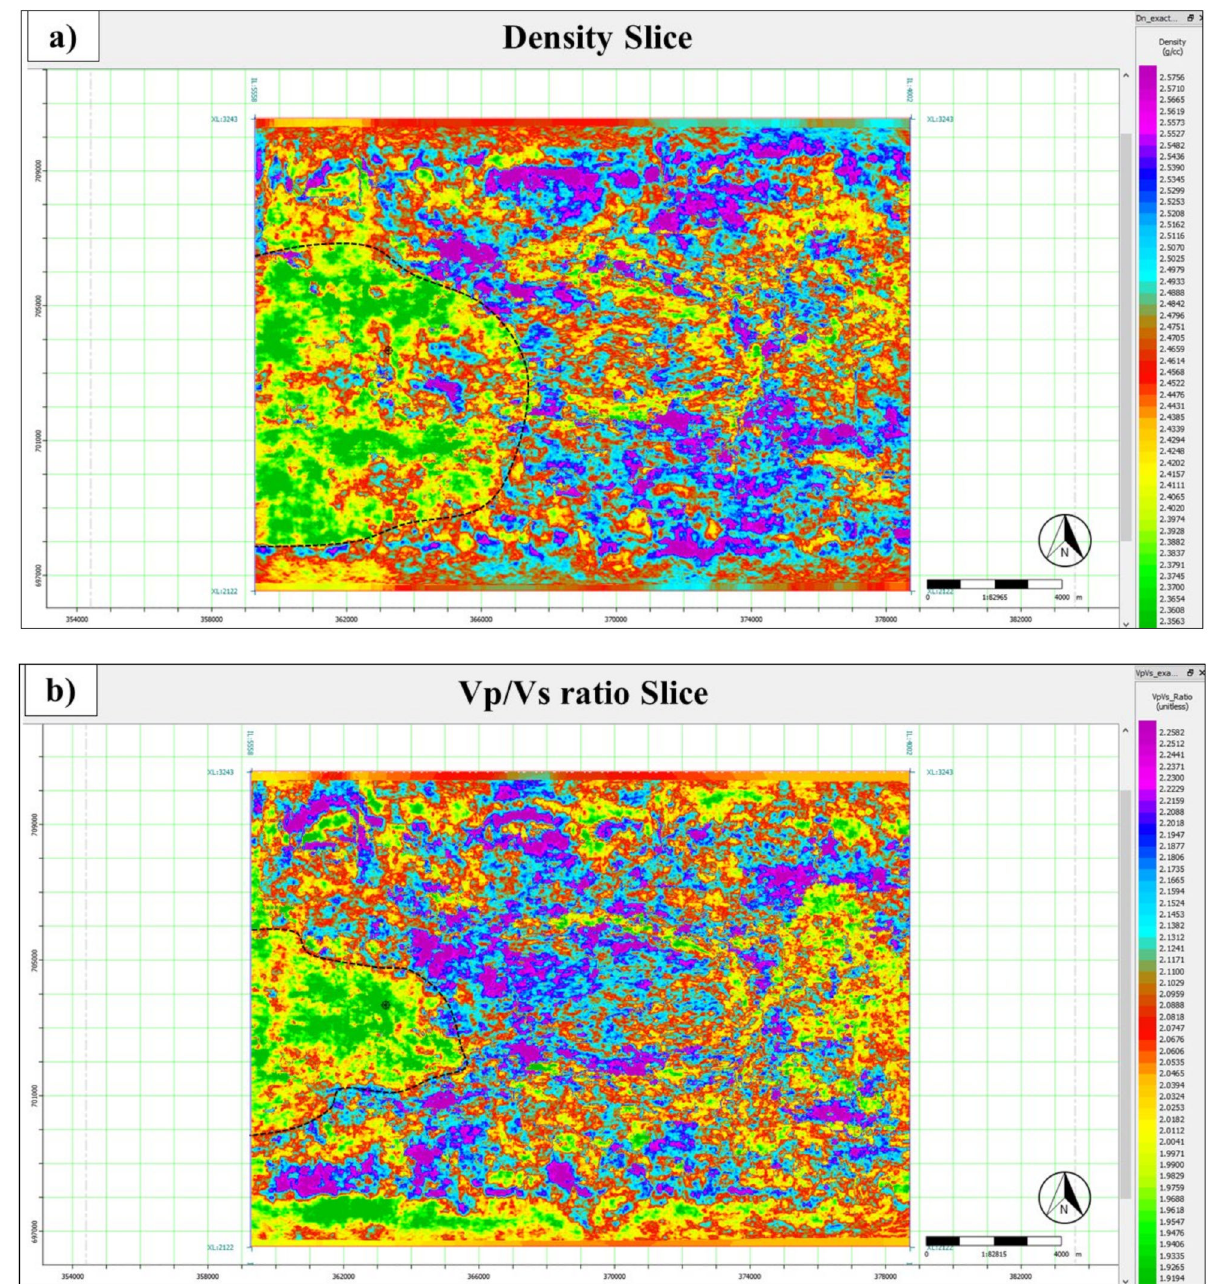
Figure 20. ( a ) Averaged density data horizon slice within an interval between Top H and H60 horizons; ( b ) Averaged Vp/Vs ratio data horizon slice within an interval between Top H and H60